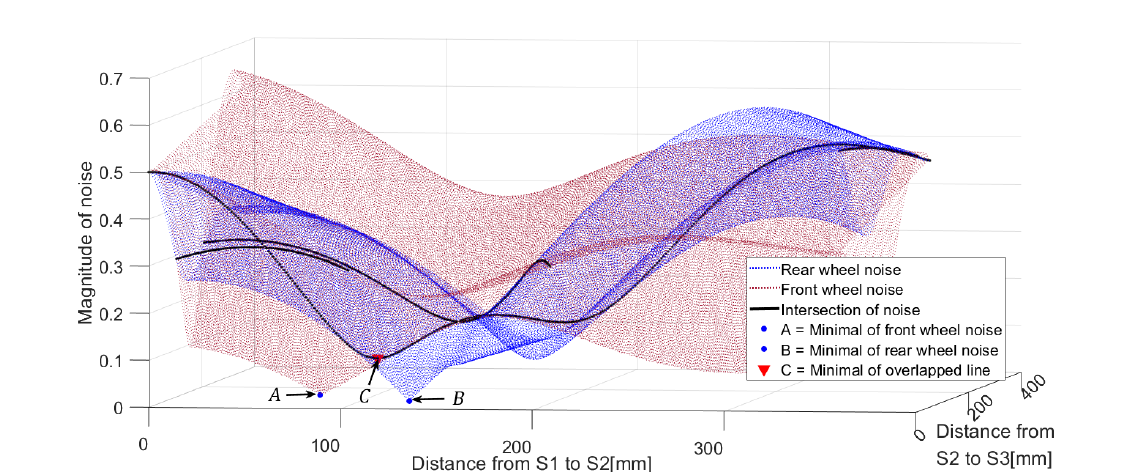
Figure 12. Magnitude of wheel noise.